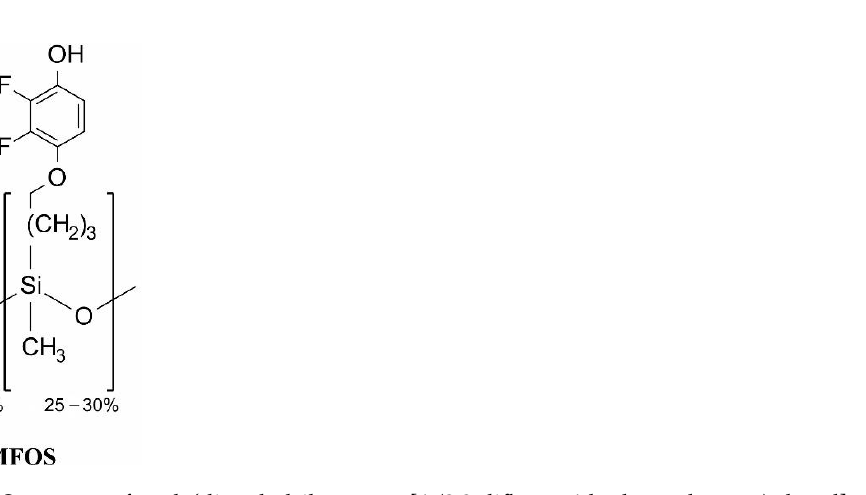
Figure 2. Structure of poly{dimethylsiloxane- co -[4-(2,3-difluoro-4-hydroxyphenoxy) butyl] me- thylsiloxane} — PMFOS.